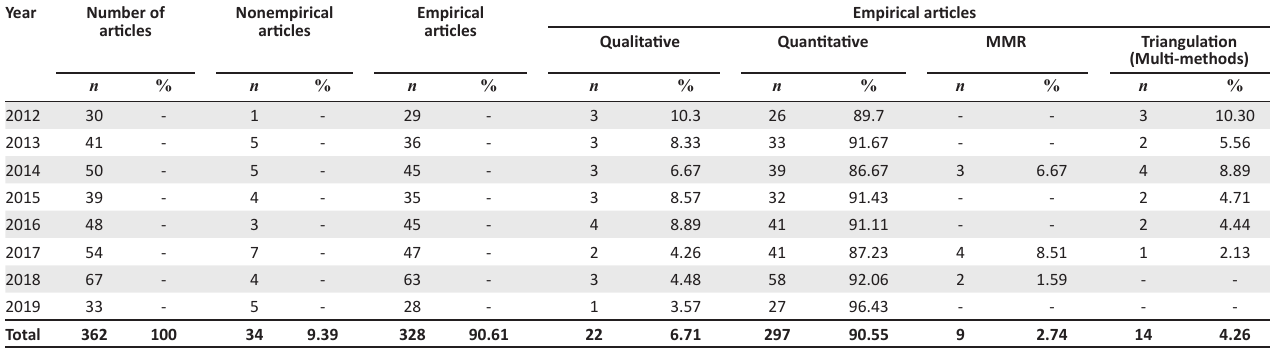
TABLE 1: Prevalence frequencies of each research approach